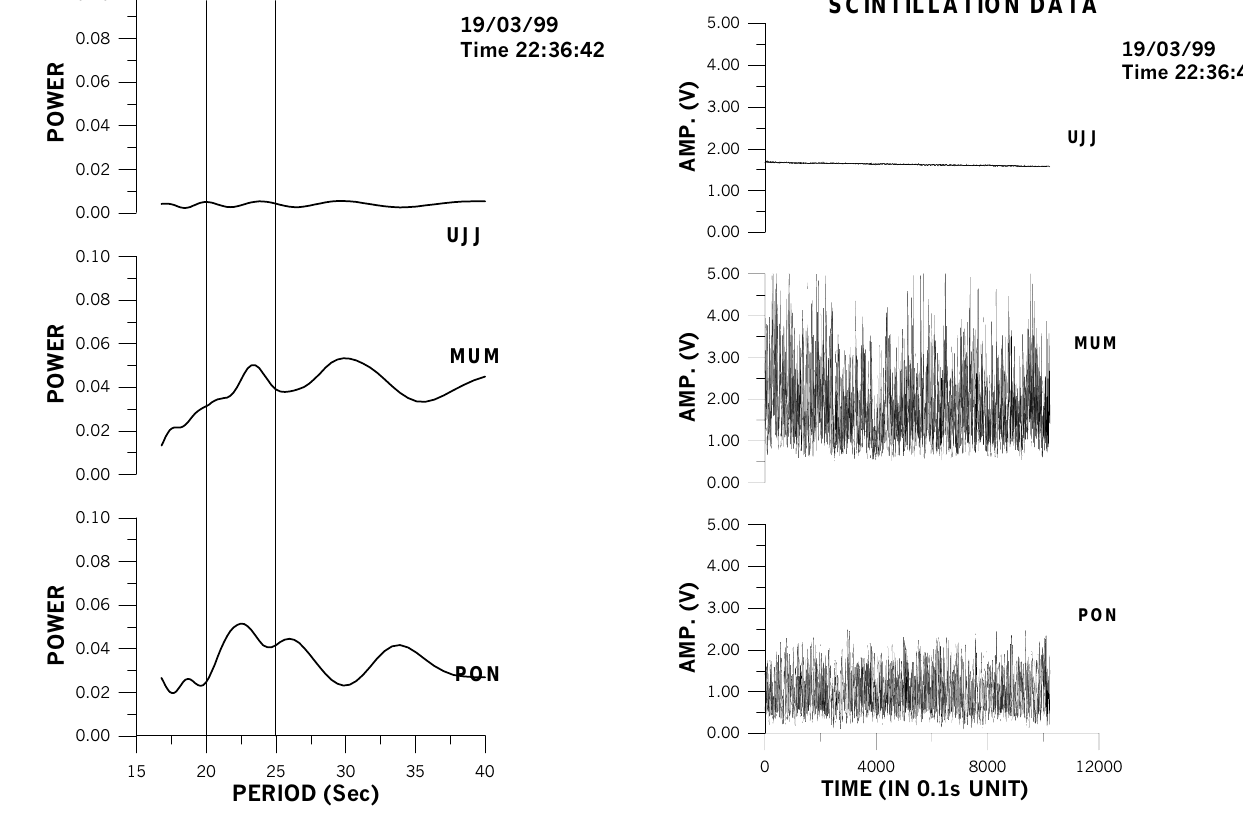
Fig. 8. Scintillations at the same time as specified in Fig. 7. The plot shows quite a significant scintillation at Pondicherry and Mumbai, whereas for Ujjain, the scintillations are not so